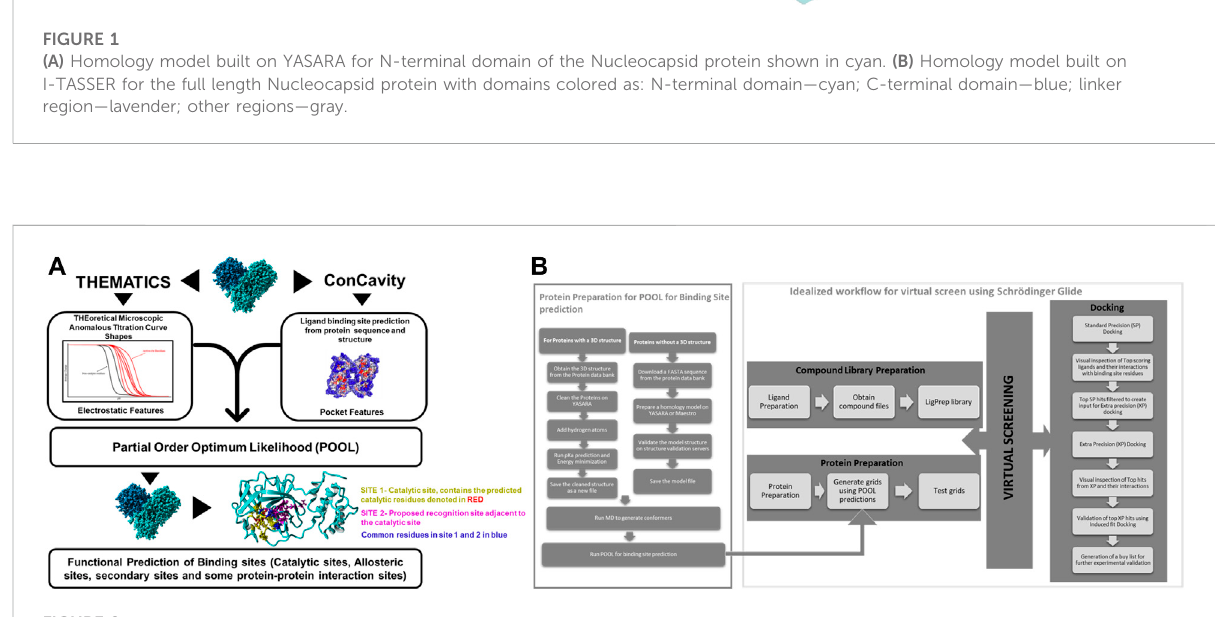
FIGURE 2 (A) AschematicrepresentationofPartialOrderOptimumLikelihood(POOL),ourmachinelearningmethodtopredictbiochemicallyactivesites. (B) Virtual screening work fl ow adopted in this project in conjunction with